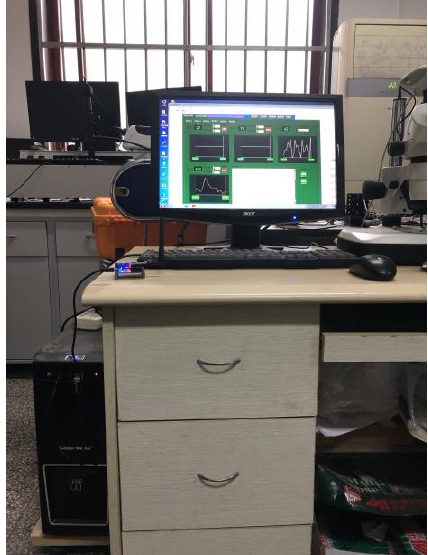
Figure 11. The local monitoring platform.